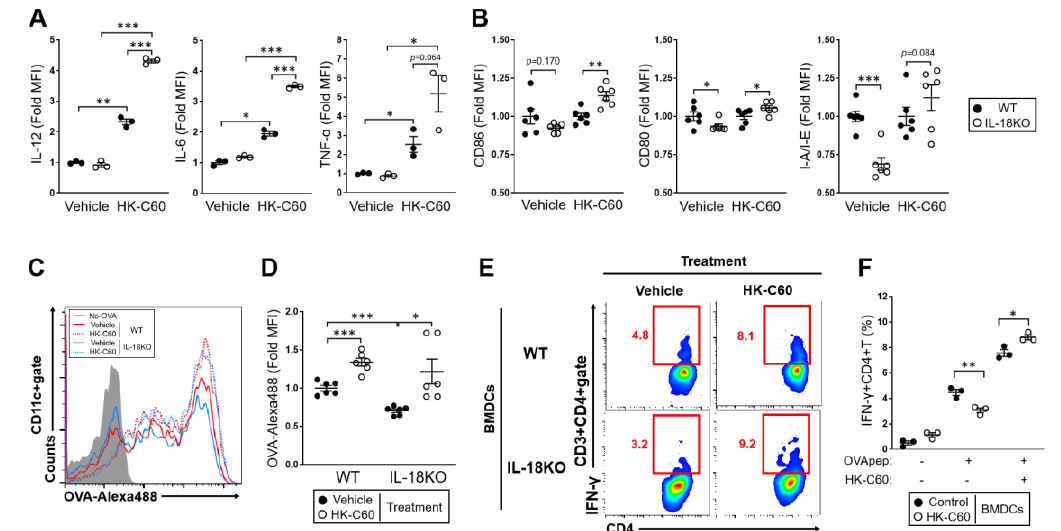
Figure 4. The function of IL-18-deficient DCs is enhanced by HK-C60 stimulation. ( A ) Intracellular cytokine detection in HK-C60 stimulated BMDCs. The BMDCs were treated with HK-C60 or vehicle control at 37 ◦ C for 6 h in the presence of GolgiStop TM . The cytokine expressions in CD11c + gate were analyzed by flow cytometry. The MFIs were calculated from the analysis. ( B ) Cellular activation of HK-C60 stimulated BMDCs. The BMDCs were treated with HK-C60 or vehicle control at 37 ◦ C for 24 h. The expression of CD80, CD86 and I-A / I-E in CD11c + gate were analyzed by flow cytometry. The MFIs were calculated from the analysis. ( C , D ) Antigen uptake assay in BMDCs. BMDCs were co-incubated with OVA-Alexa 488 with or without HK-C60. The representative image of OVA uptake in flow cytometry ( C ) and the MFIs indicated the signal from uptaken OVA-Alexa 488 ( D ) in the analysis. ( E , F ) Antigen presentation assay to CD4 + T cells. BMDCs were cocultured with DO11.10 CD4 + T cells (1:5) in the presence of OVA 323–339 peptide with or without HK-C60 stimulation at 37 ◦ C for 72 h. At the last 5 h, the cells were re-stimulated with PMA / Ionomycin combined with GolgiStop TM . The IFN- γ + CD4 + T (Th1) cells were analyzed by flow cytometry. The representative image of Th1 cell population ( E ) and the percentage of Th1 cells ( F ) in CD3 + CD4 + gate in the analysis. The data were shown as the representative or mean ± SEM of at least three samples in three independent experiments. Each dot indicates the data from one sample. A Mann–Whitney U test was used to analyze data for significant di ff erences. Values of * p < 0.05, ** p < 0.01, and *** p < 0.001 were regarded as significant. Taken together, HK-C60 promotes CD4 + T cells activity such as IFN- γ production and cell proliferation, which are induced by TCR-dependent stimulation, in PP of IL-18KO